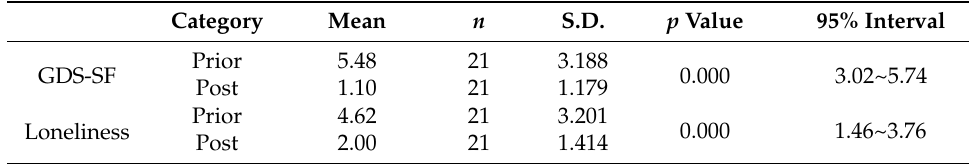
Table 4. Results of Paired t